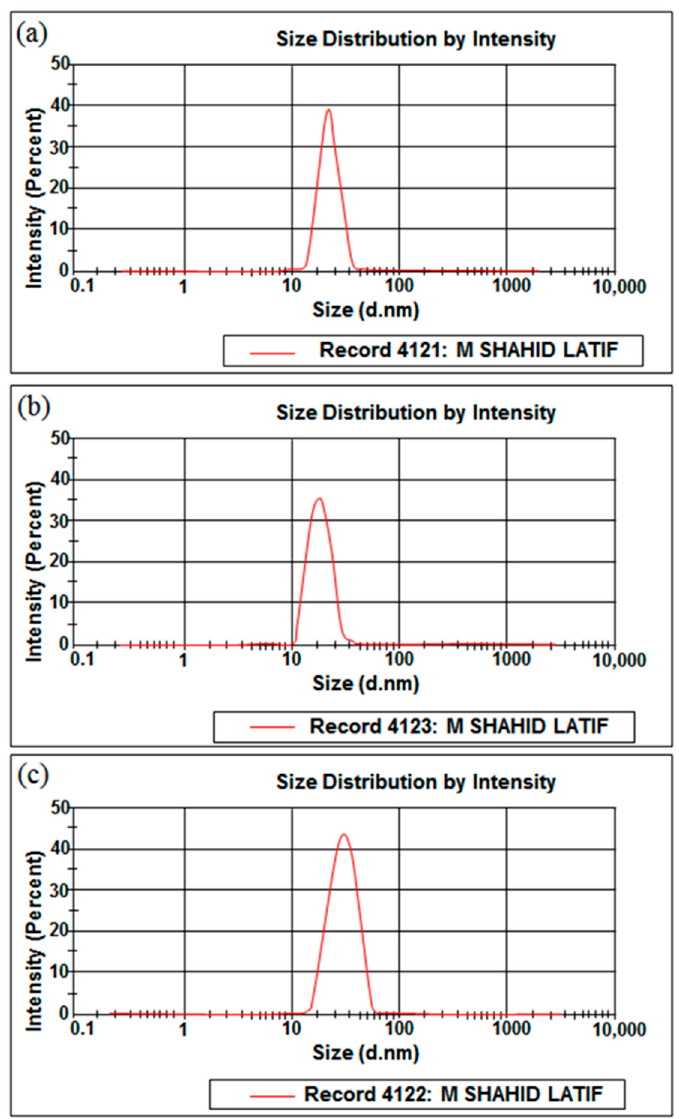
Figure 3. Zeta size of ( a ), FNE2, ( b ), FNE4, and ( c ) FNE6.